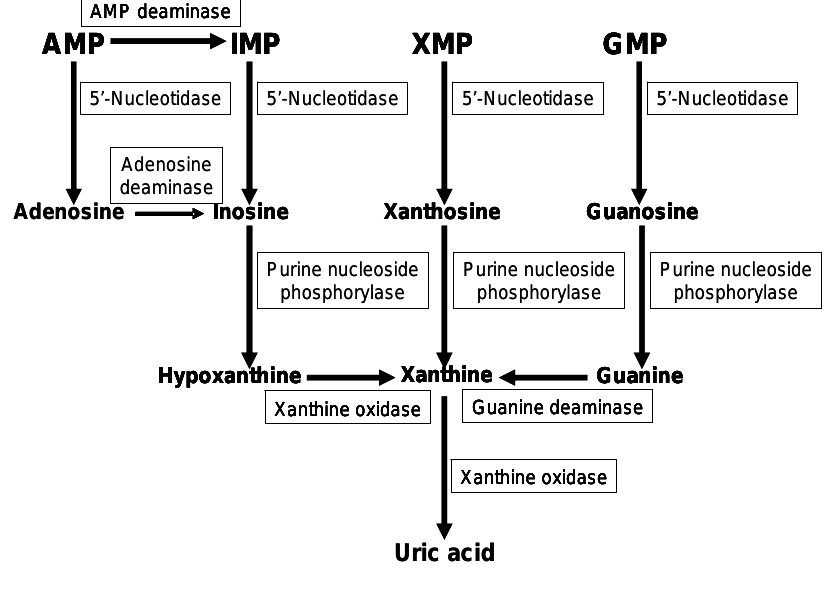
Figure 2. Metabolic pathways of uric acid formation from nucleotide